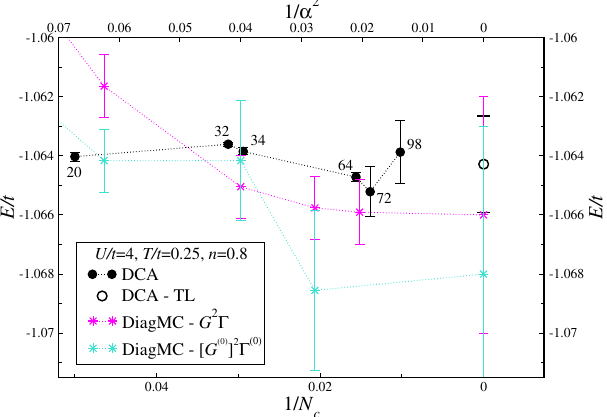
FIG. 2. Energies obtained at U=t ¼ 4 , T=t ¼ 0 . 25 and n ¼ 0 . 8 from G 2 Γ (magenta) and ½ G ð 0 Þ (cid:4) 2 Γ ð 0 Þ (turquoise) as a function of the inverse square of the diagram order parameter α (upper axis label) along with DCA results obtained from finite clusters plotted against the inverse of the cluster size N c (lower axis